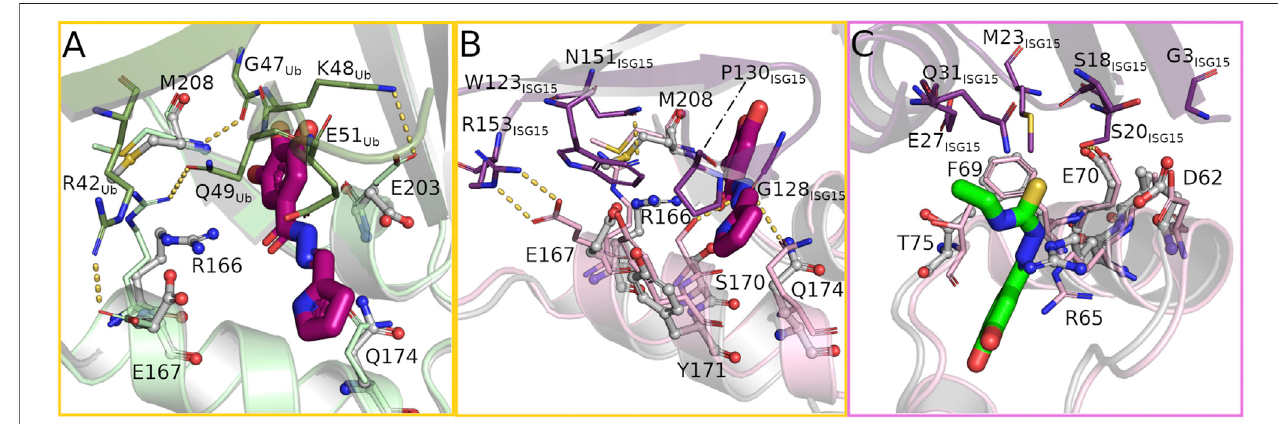
FIGURE4| TheboundcompoundsinterferewithkeyresiduesforsubstratebindingattheS1(yellowframe)andS2(pinkframe)site. (A) Overlayofubiquitinbound to PLpro (PDB: 6xaa, PLpro light green, ubiquitin green) and the hydrazone bound structure (PLpro grey, H1 magenta) showing the rearrangement of several PLpro- ubiquitininteractingside chainstoform hydrogen bondswiththecompound. (B,C) Overlay ofPLpro complexed withhuman ISG15 (PDB: 7rbs,PLpro lightpink, ISG15 purple) and PLpro bound with hydrazone H1 and thiosemicarbazone T2 (PLpro grey, H1 magenta, T2 green) at the S1 and S2 sites respectively highlighting the structural differences in binding the compound or